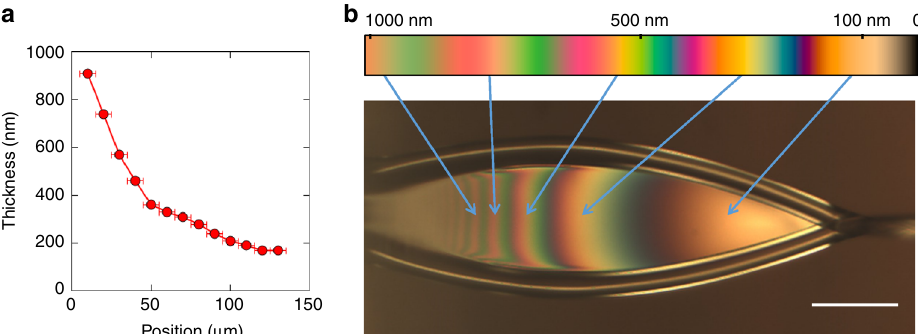
Fig. 4 Optical characterization of liquid sheets. The thickness of a liquid sheet is measured by spectral re fl ectance, as described in the text, and plotted in a as a function of position along the sheet, starting at the far left arrow in b . The error bars in a represent the 10 μ m sampling size of the measurement. The color bar above the image in b is a simulation of the observed re fl ected color for water fi lms, as a function of thickness, as described in the text. Arrows indicate the corresponding fringes on the liquid sheet, in agreement with the spectral re fl ectance measurements of a . The scale bar in a is 50 μ